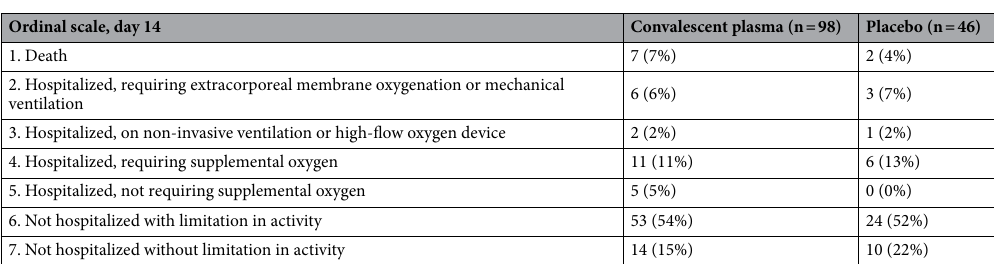
Table 2. Worst scores for Covid-19 severity at 14 days according to a 7-category ordinal scale.